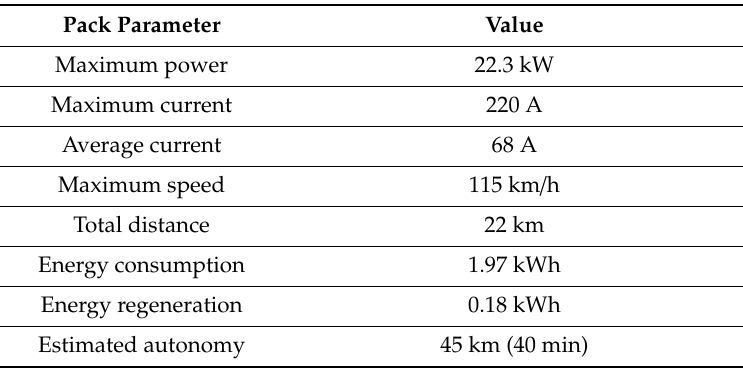
Table 5. FK1 test Table 5. FK1 test results. Table 5. FK1 test results.